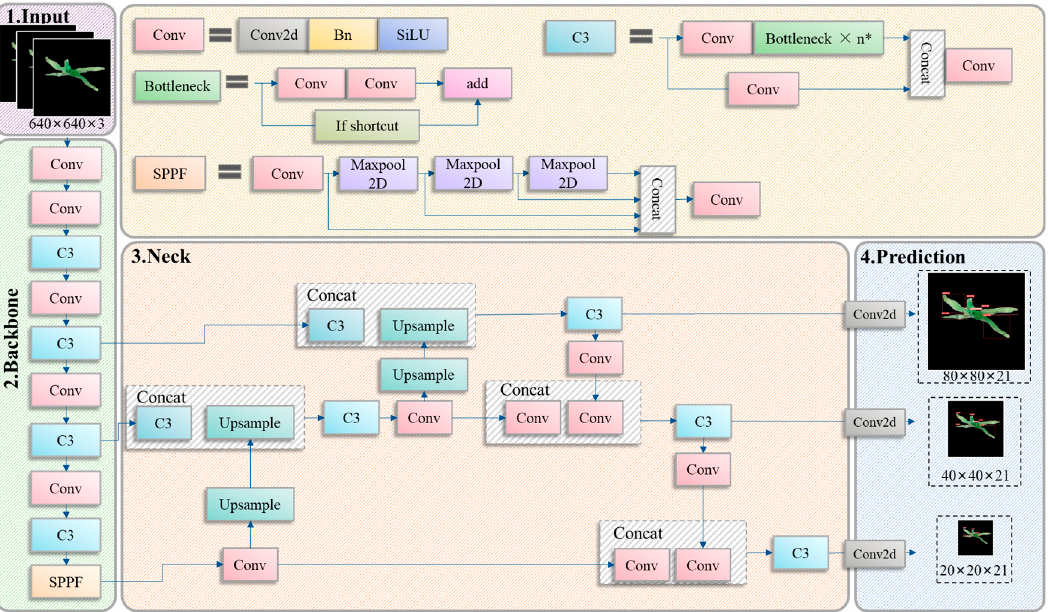
Figure 4. YOLOv5 network structure. Conv is the convolution module, which consists of Conv2d (convolution unit), BN (batch normalization), and SiLU (activation function). C3 is the bottleneck layer. Bottleneck is the residual block. Maxpool2D is the maximum pooling. SPPF is fast spatial pyramid pooling. Upsample is upsampling. Concat is the channel-connected feature fusion method.